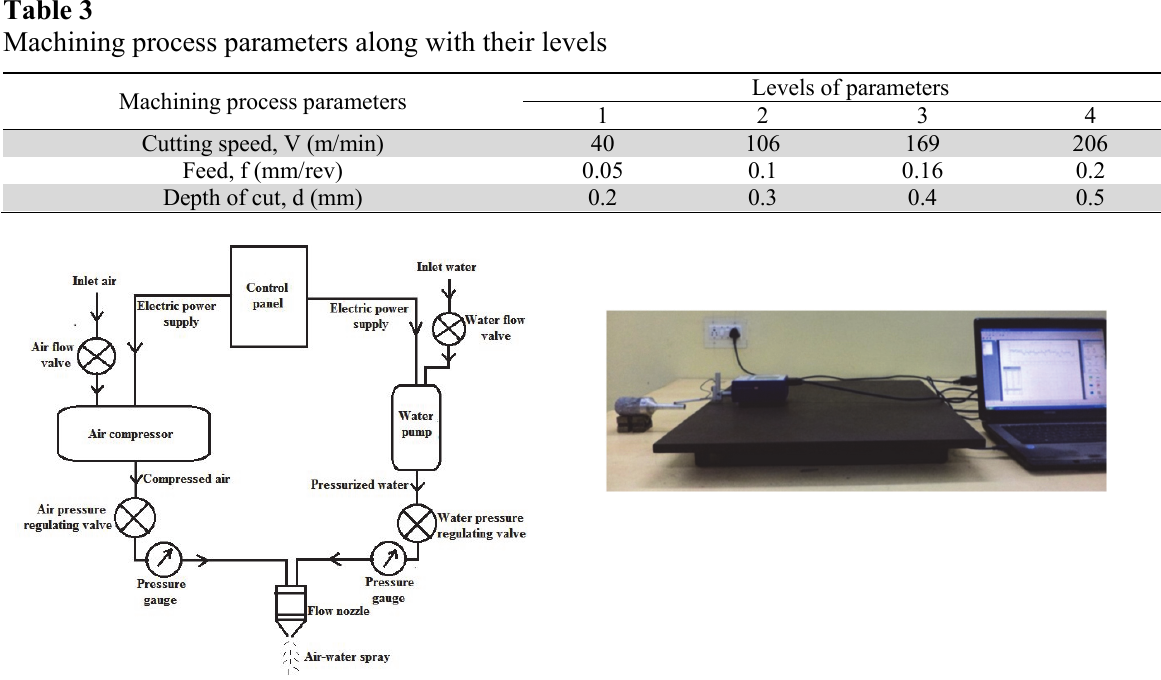
Fig. 3. Schematic of the SIC setup Fig. 4. Measurement of surface